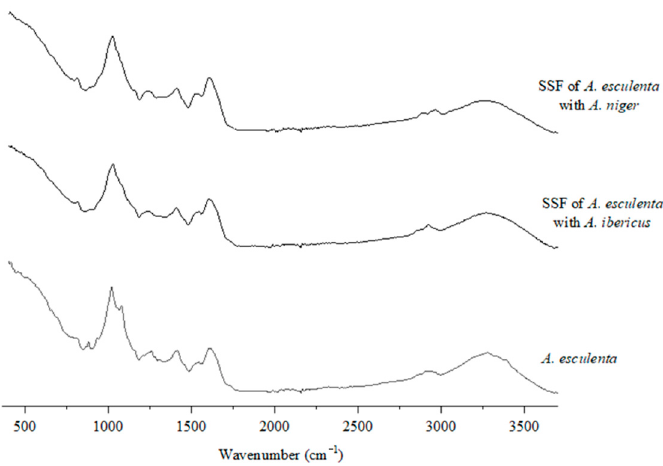
Figure 5. FTIR-ATR spectra of brown seaweed. Typical bands of agar samples were identified in the unfermented Gracilaria sp. (Figure 3): the 930 cm − 1 band is related to the C–O vibration of LA units, the 1250 cm − 1 band is assigned to the S=O stretching vibration, and the 1370 cm − 1 band, which is